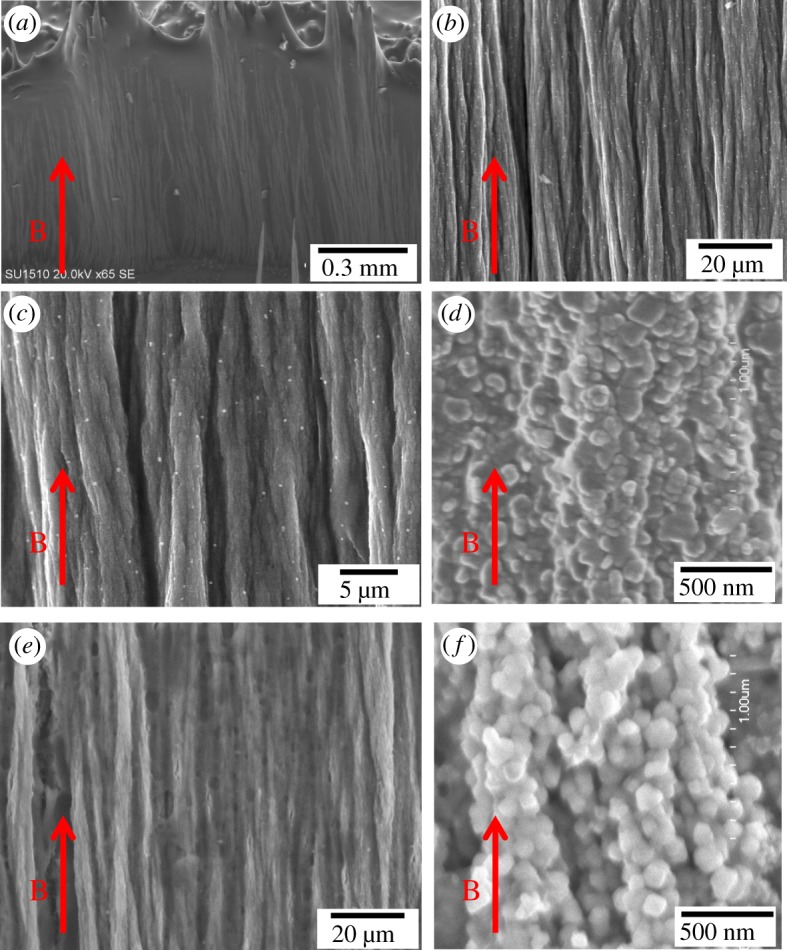
SEM images with different magnifications of fabricated arrays assembled from (a–d) core–shell α″-Fe16N2/Al2O3 MNPs and (e,f) Fe3O4 MNPs under an EMF of 15 T.